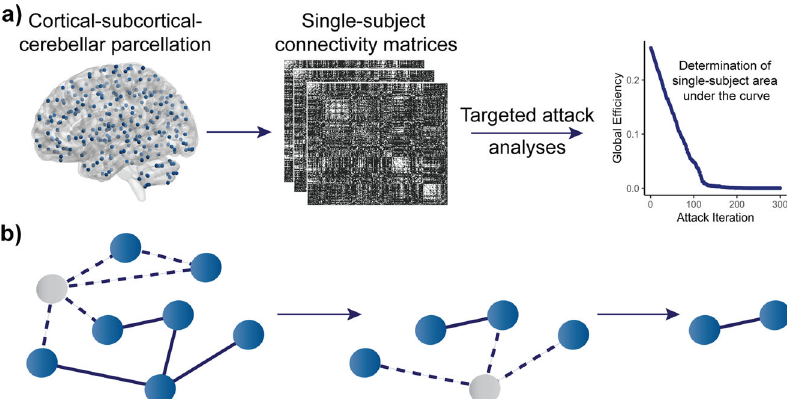
Fig. 5 Imaging and network-attack analysis pipeline. a Summary of methodology. Using a functionally de fi ned 300-node parcellation, weighted connectivity matrices were computed and binarized; network-attack analyses were performed on these single-subject connectivity matrices. b Network graphs depicting network nodes and edges as circles and lines. Targeted-attack analysis involves the iterative removal of nodes in an ordered fashion, starting with the node with the highest degree, followed by the node with the next-highest degree, and so on. Gray nodes and the corresponding dotted lines represent the nodes and subsequent edges removed in each attack